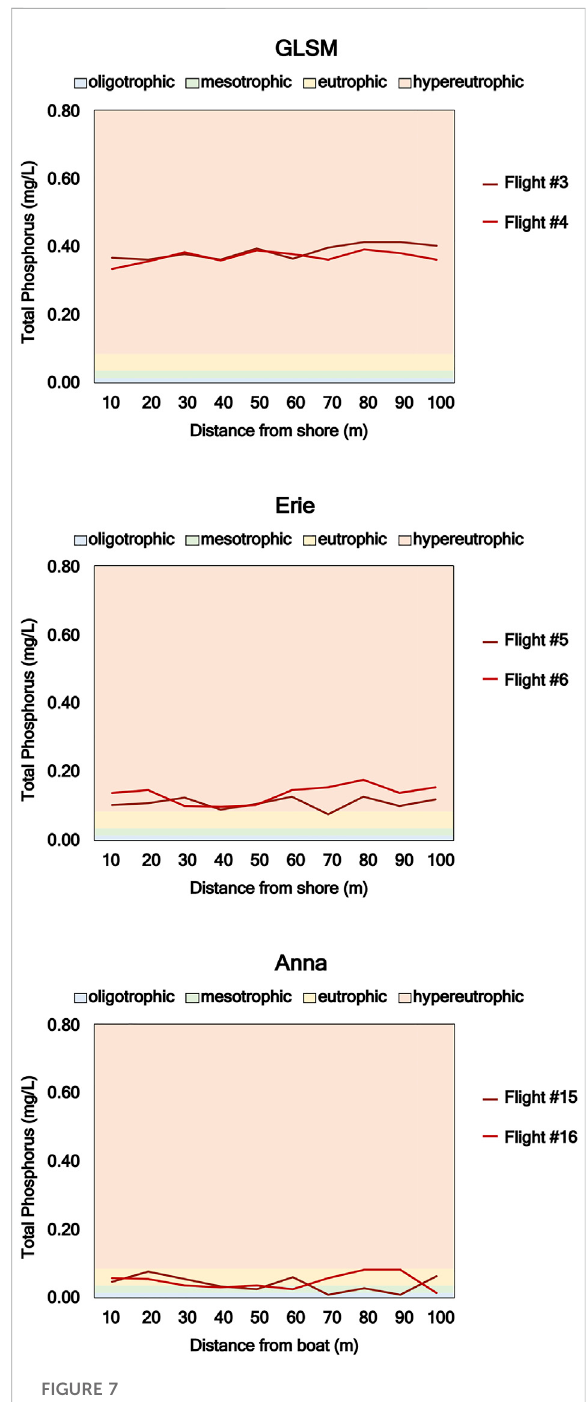
FIGURE 6 The concentration of PC from each transect location is shown for two consecutive fl ights from each lake. Distance across the 100 m transect is shown on the x-axis. PC concentration in ppbisshownonthey-axiswithascaleof0 – 800 ppb(GLSM), orascaleof0 – 140 ppb(LakeErieandLakeAnna).Thecolorbands represent Alert level 1 (blue), Alert level 2 (green), Alert level 3 (yellow), and Action level (orange). The water quality metrics are shown in Table 1 and correspond to the trophic state lake classi fi cations of oligotrophic, mesotrophic, eutrophic, and